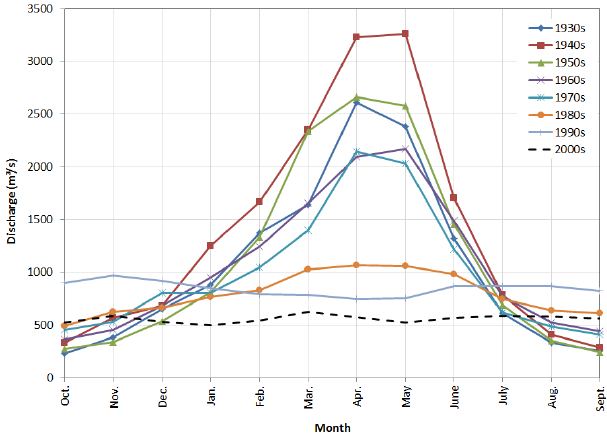
Figure 5. Decadal hydrographs of River Tigris at Sarai Baghdad for the period 1930-2013.